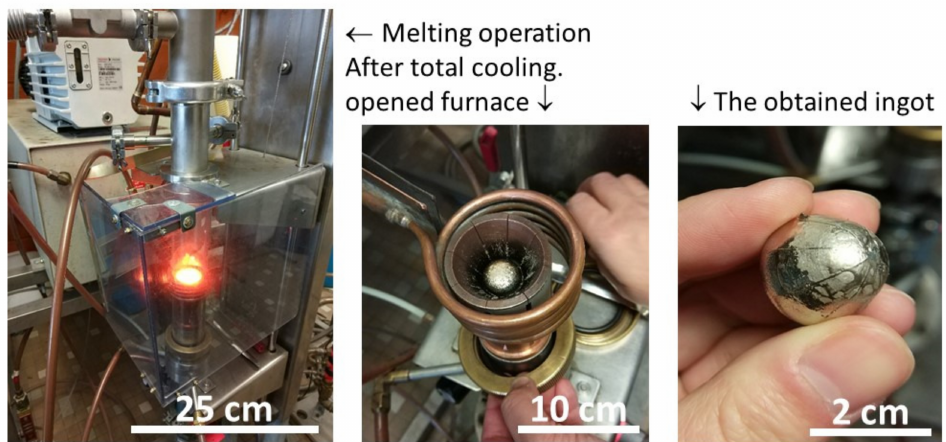
Figure 1. The melting alloy ( left ), the obtained ingot still in the crucible ( middle ), and after its extraction ( right